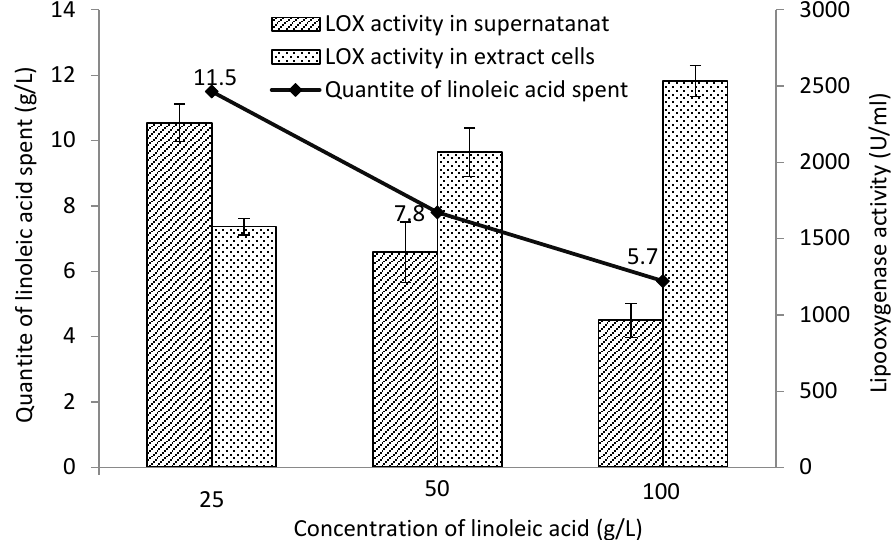
Figure 5. The influence of the concentration of linoleic acid on the quantity consumed by the yeast Yarrowia lipolytica and its lipoxygenase activity. Table 4. Influence of linoleic acid concentration on the level of hexanal biosynthesis by Yarrowia lipolytica yeasts.